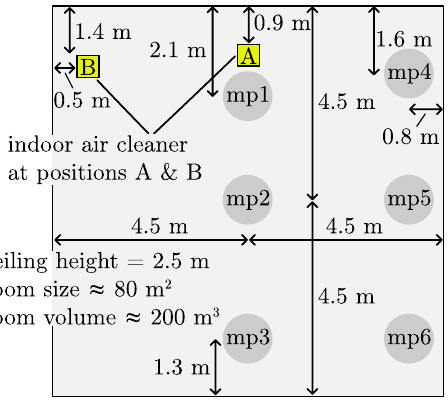
Figure 1. Config. I : the 80 m 2 room and the measurement locations (mp1–mp6). Figure not to scale with Figure 2.